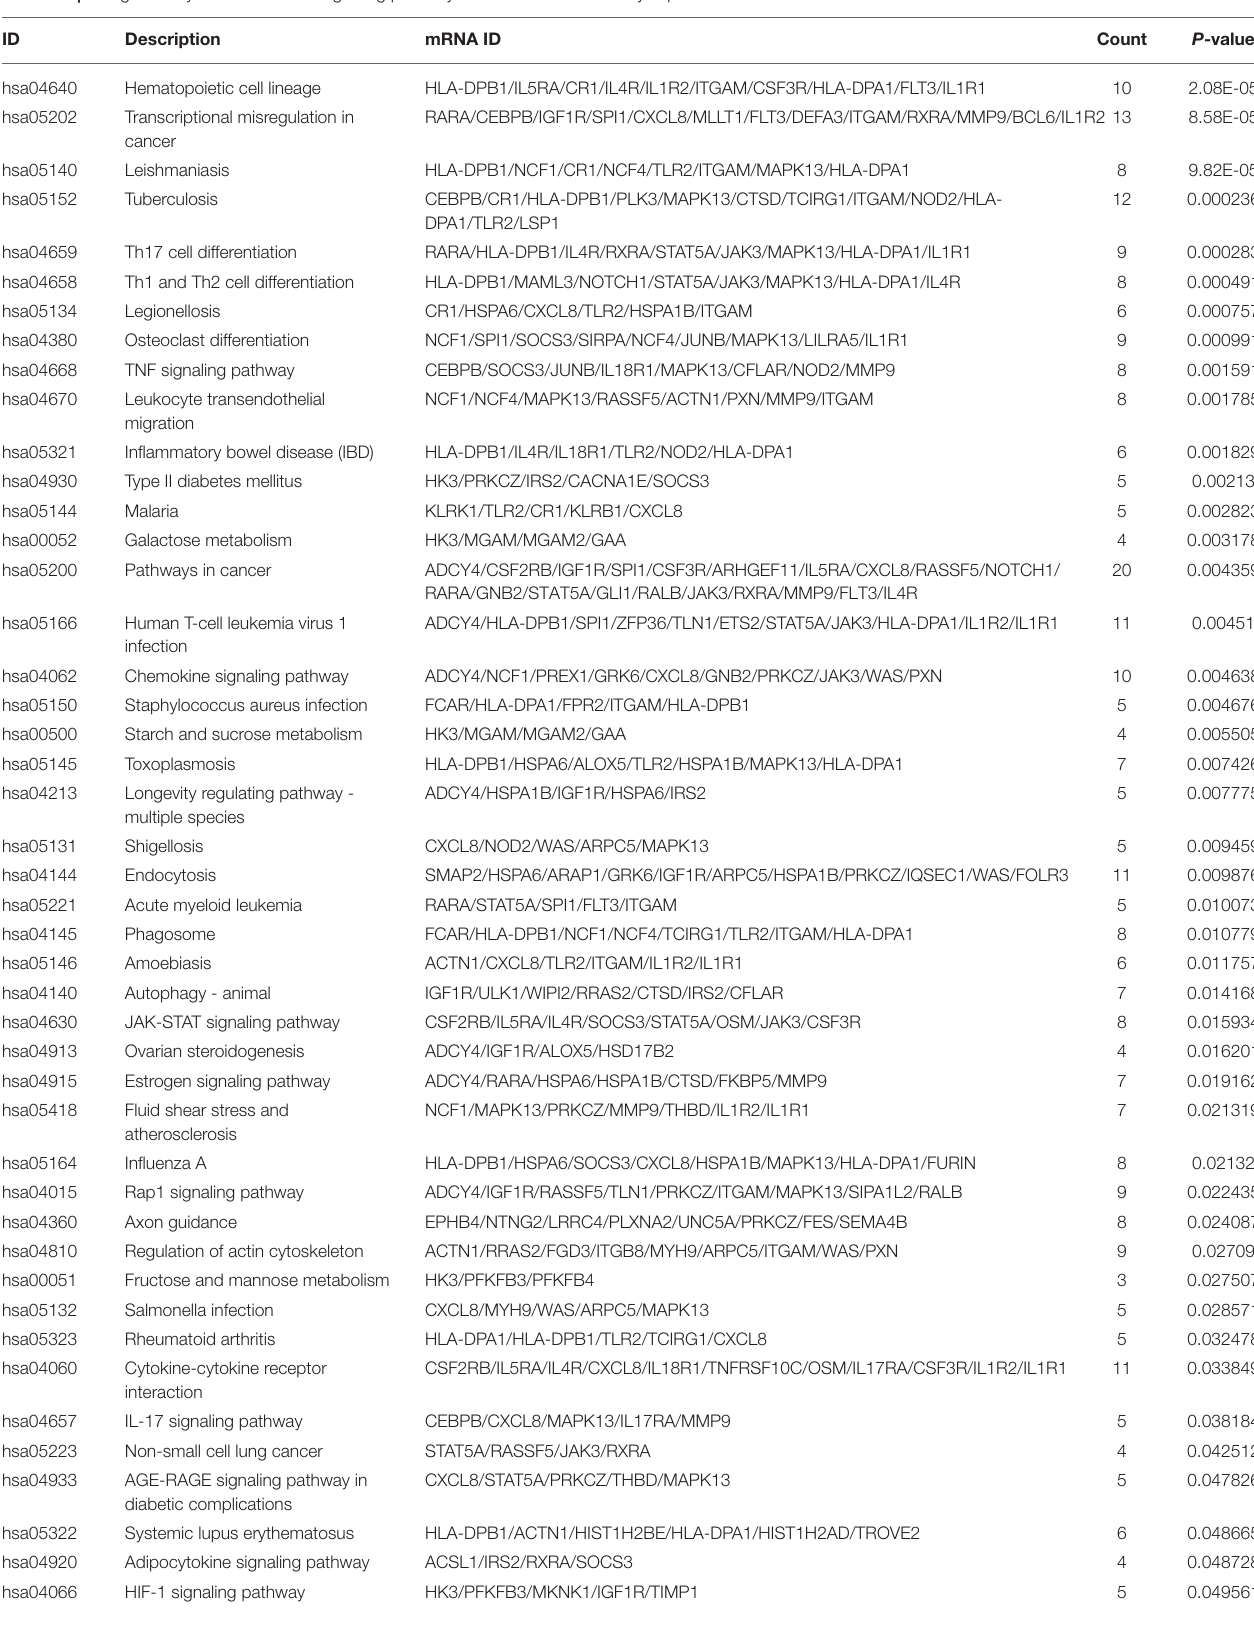
TABLE 6 | All significantly enriched KEGG signaling pathways of common differentially expressed mRNAs between MF vs. AMI and HF vs.